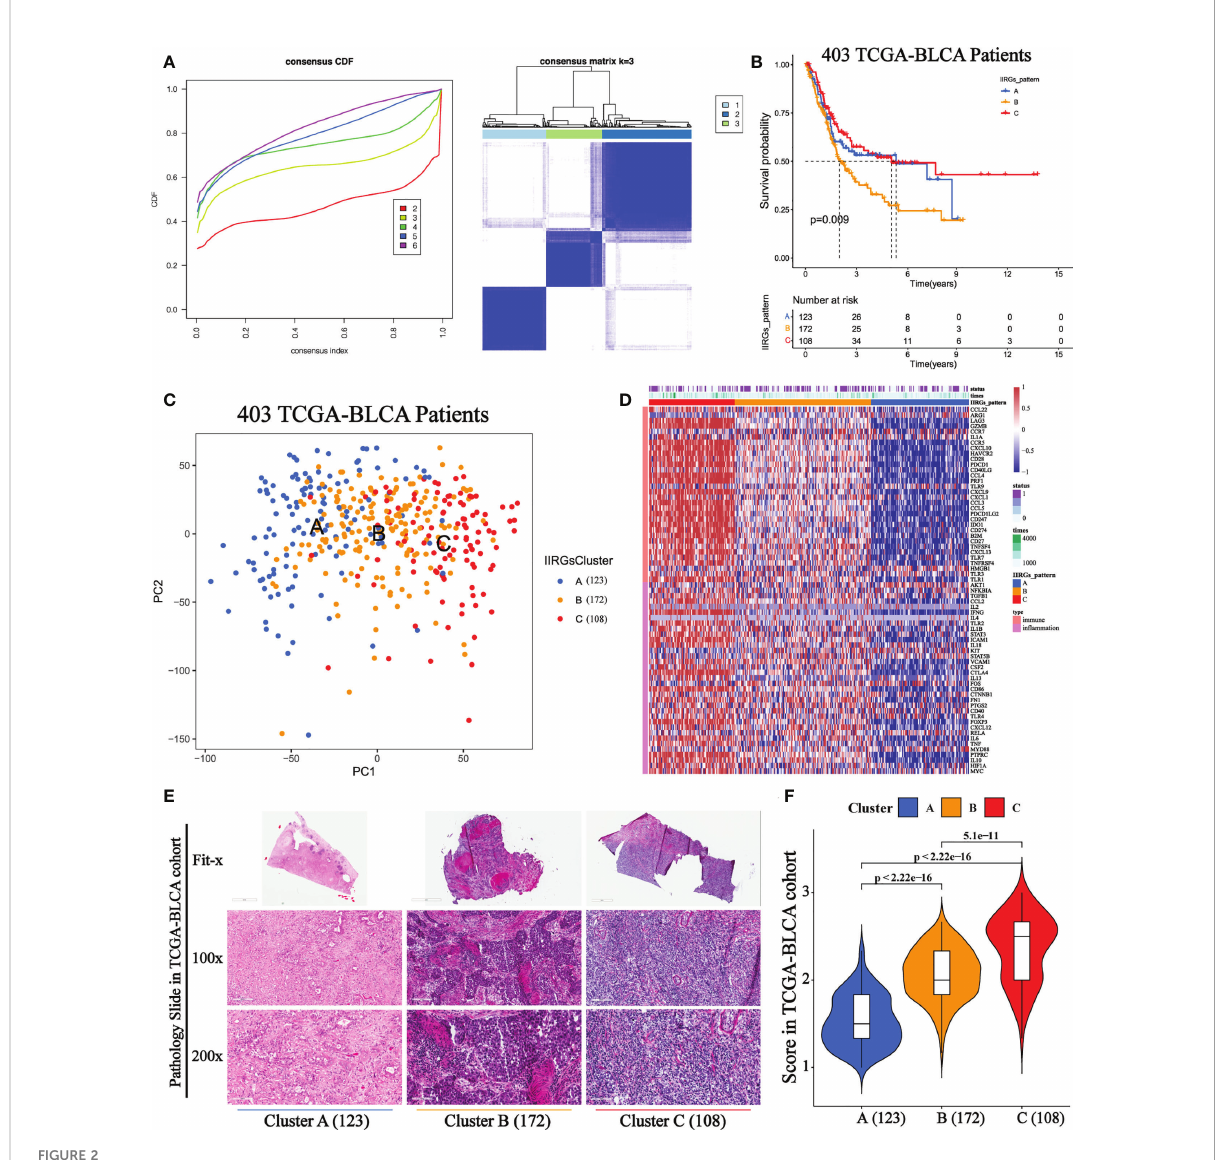
FIGURE 2 Unsupervised consensus cluster analysis of IIRGs in TCGA-BLCA cohort. (A) Heatmap of consensus clustering matrix for k =3 and Consensus clustering cumulative distribution function (CDF) for k = 2 to 6. (B) KM curves of OS among clusters in BLCA. (C) PCA among three IIRG modi fi cation patterns. (D) Hierarchical clustering of IIRGs in TCGA-BLCA cohort. (E) Representative photomicrographs of H&E staining of bladder sections among clusters. (F) The One-way ANOVA analysis of histopathological scores among